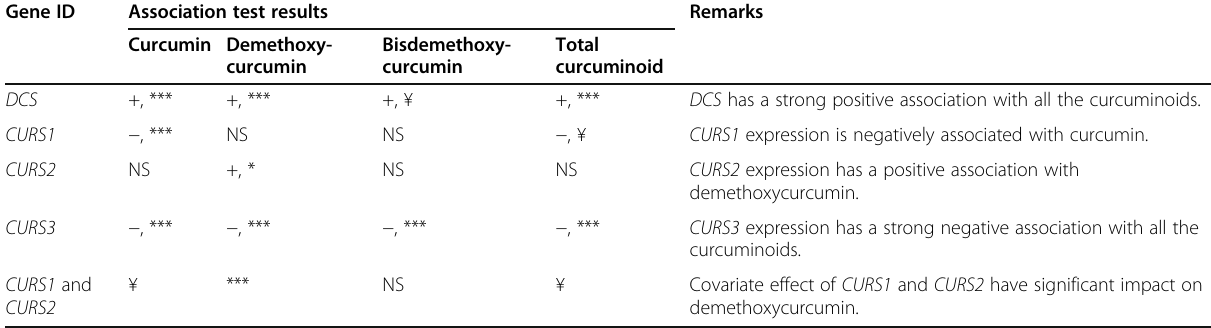
Table 7 Summary of the association-based tests between gene expression and